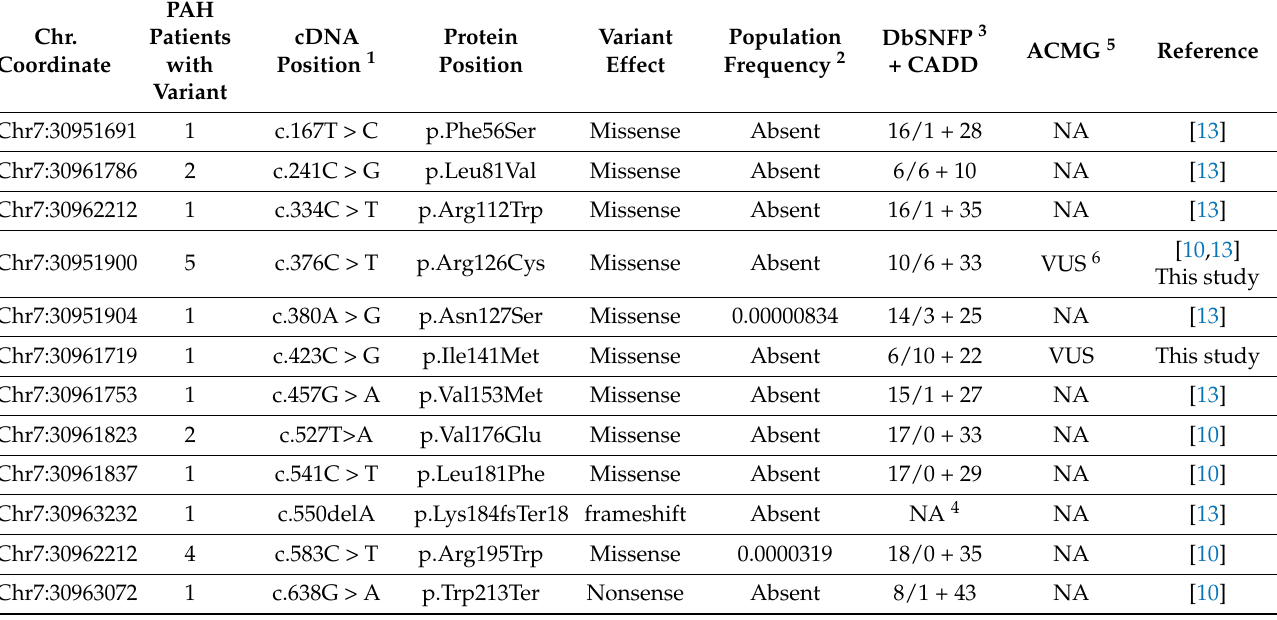
Table 2. Information of variants in AQP1 described in PAH cases.